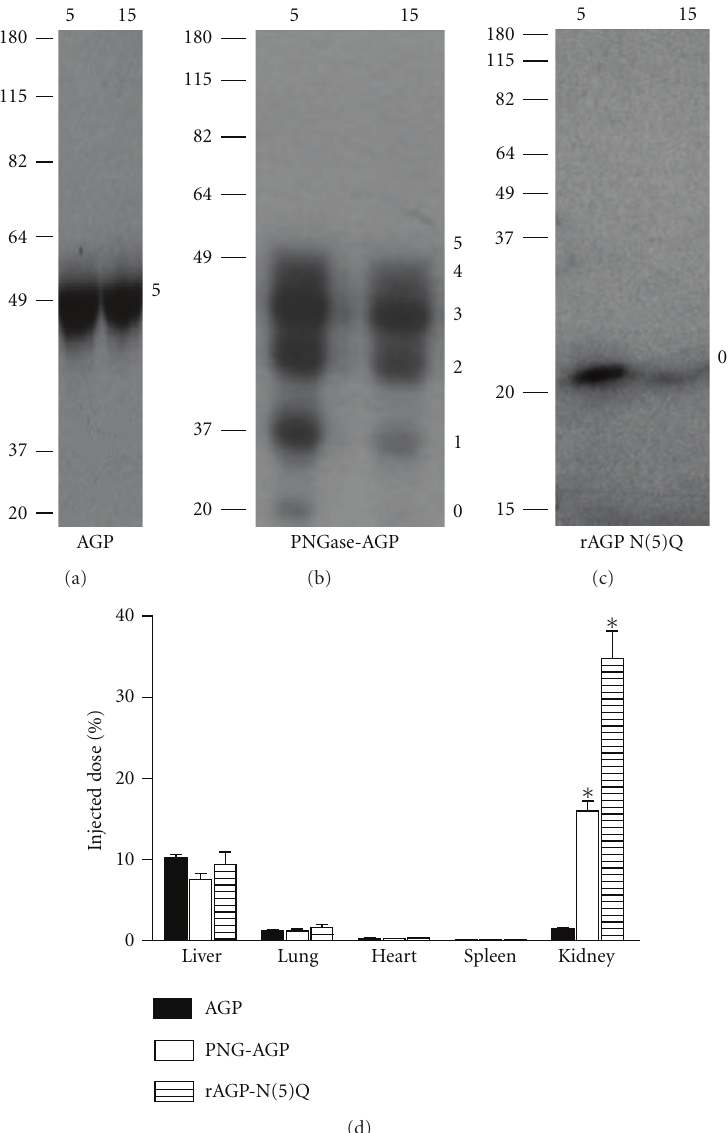
Figure 3: Forms of AGP with reduced glycosylation are cleared from the rabbit circulation and distribute to the kidneys more rapidly than native AGP. Plasma from rabbit injected with radioiodinated proteins (identified below (a)–(c)) was electrophoresed on reduced SDS-PAGE gels; autoradiograms of samples taken 5 and 15 minutes after injection are shown. Molecular mass markers in kDa are shown at left, and the deduced number of N-linked glycan chains at right. (d) Shows the percentage of the total radioactive dose of injected radioactivity found in the organs (identified below the panels) 30 minutes after injection of AGP (solid bars) or PNGase F-treated AGP (PNGase-AGP, open bars) or rAGP-N(5)Q (stippled bars). The mean of 6 determinations ± SD is shown. ∗ Indicates P < 0 . 001 versus AGP value for the other two proteins within each organ sampled; all other comparisons to AGP values within organs are not